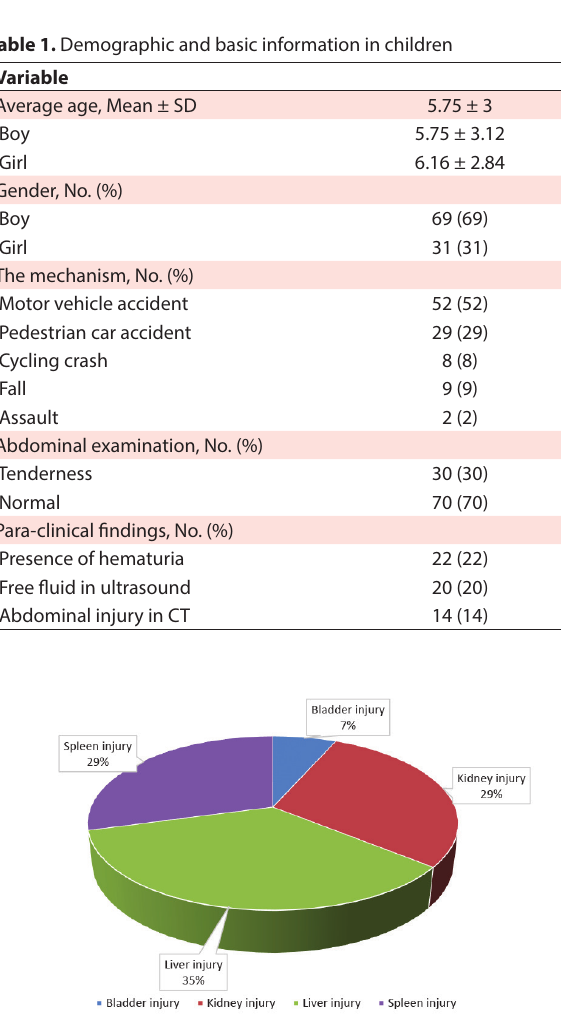
Figure 1. The percentage of injury type in patients with abnormal CT